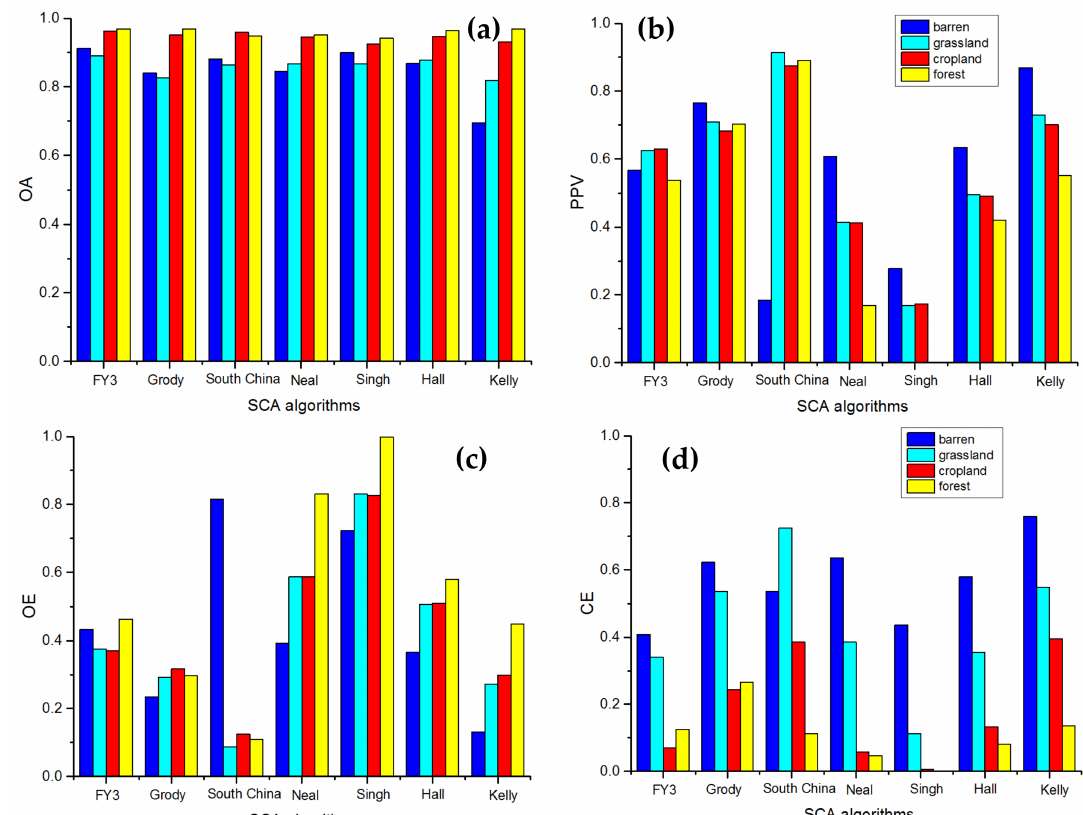
Figure 6. OA ( a ), PPV ( b ), OE ( c ) and CE ( d ) of the seven PMW SCA maps compared to station observations in different land-cover